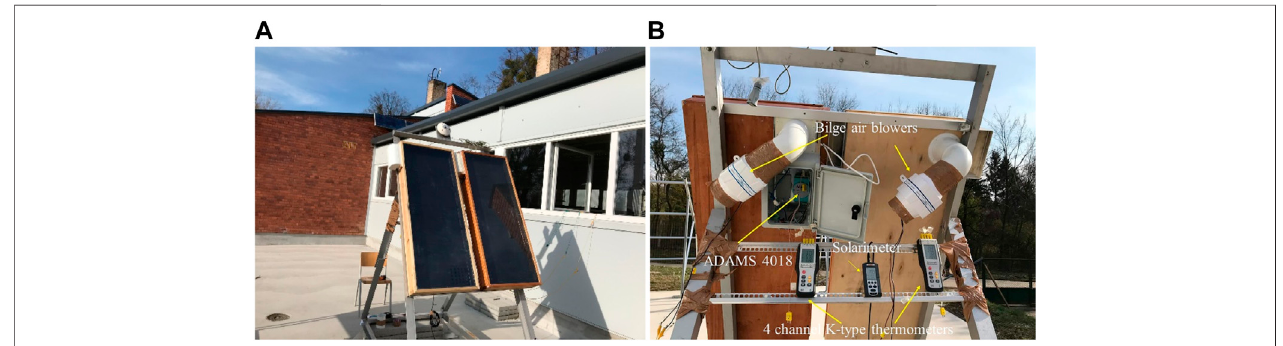
FIGURE 2 | Solar collector setup. (A) Double-pass solar collector with fi n (left) and without fi n (right); (B) solar radiation measurement setup along with thermocouples.